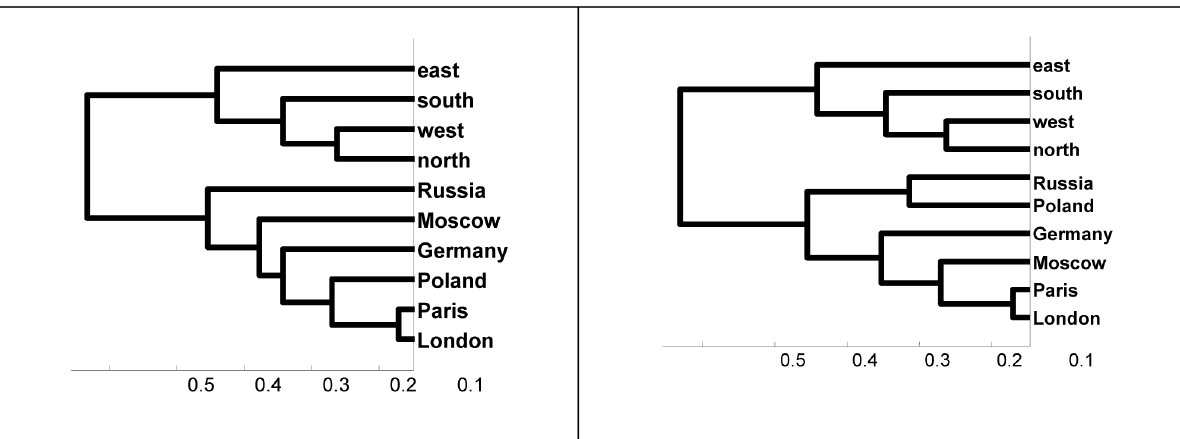
Figure 14. Hierarchical cluster trees computed from the accumulated average conditional probability density estimates obtained after 22 and 23 classifications of 640 brain wave samples (S18) for { London,Moscow,Paris,north,south,east,west,Germany,Poland, Russia }.